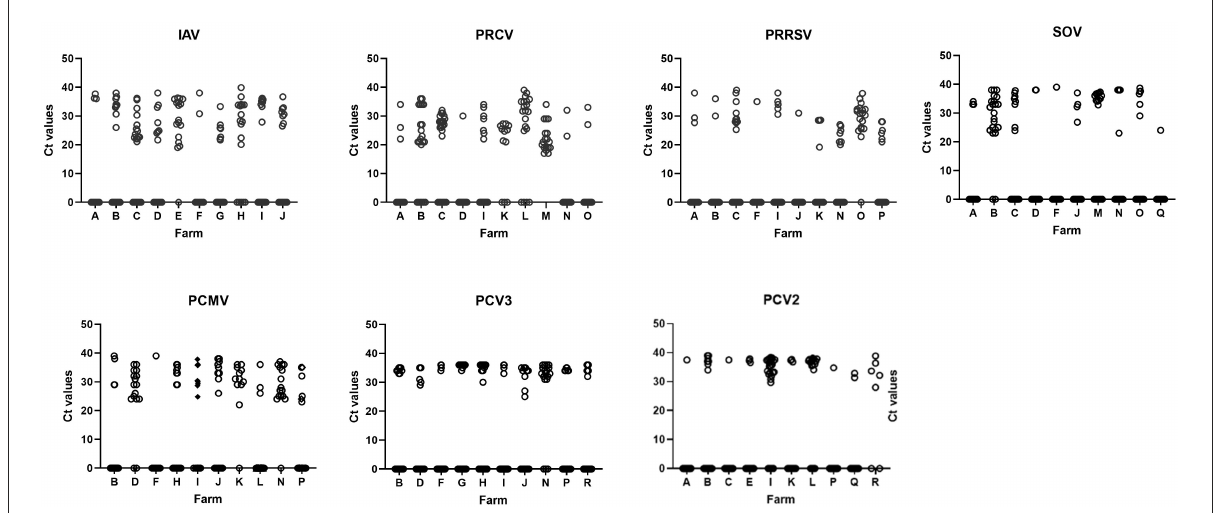
FIGURE2 The figure shows the distribution of Ct values in 10 nurseries infected by each detected virus. To simplify the graphs, values for negative animals were shown as Ct = 0. The letter in the X-axis indicates the farm code. Detailed values of prevalence, confidence intervals and average Cts are shown in Supplementary material 1. IAV, influenza A virus; PRCV, porcine respiratory coronavirus; PRRSV, porcine reproductive and respiratory syndrome virus; SOV, swine orthopneumovirus; PCMV, porcine cytomegalovirus; PCV2, porcine circovirus 2; PCV3, porcine circovirus